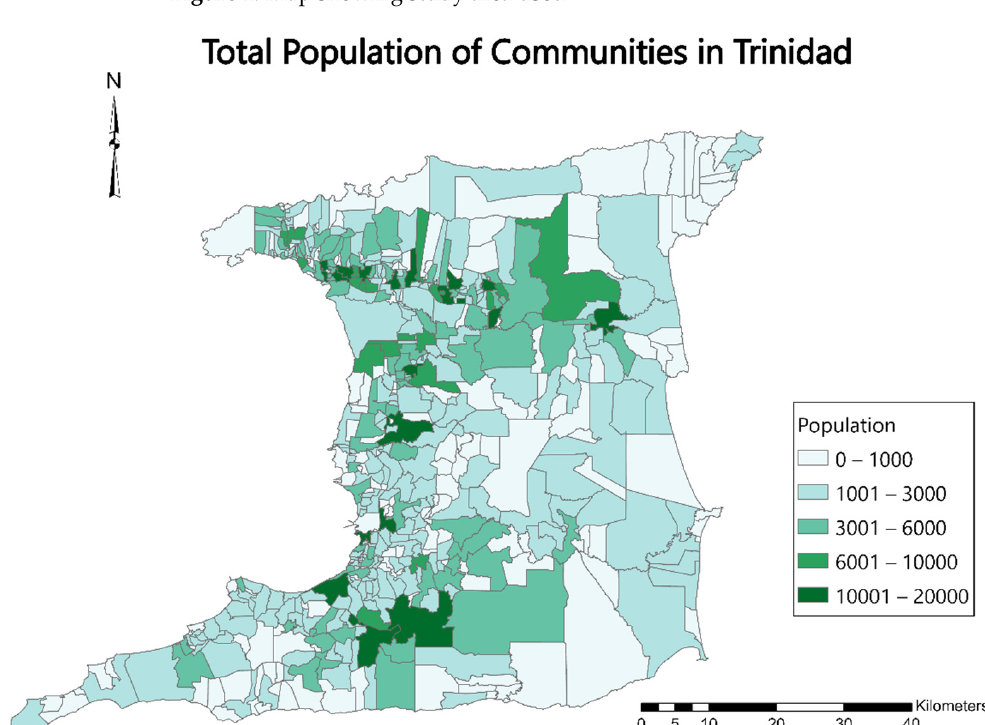
Figure 2. Population distribution in Trinidad.